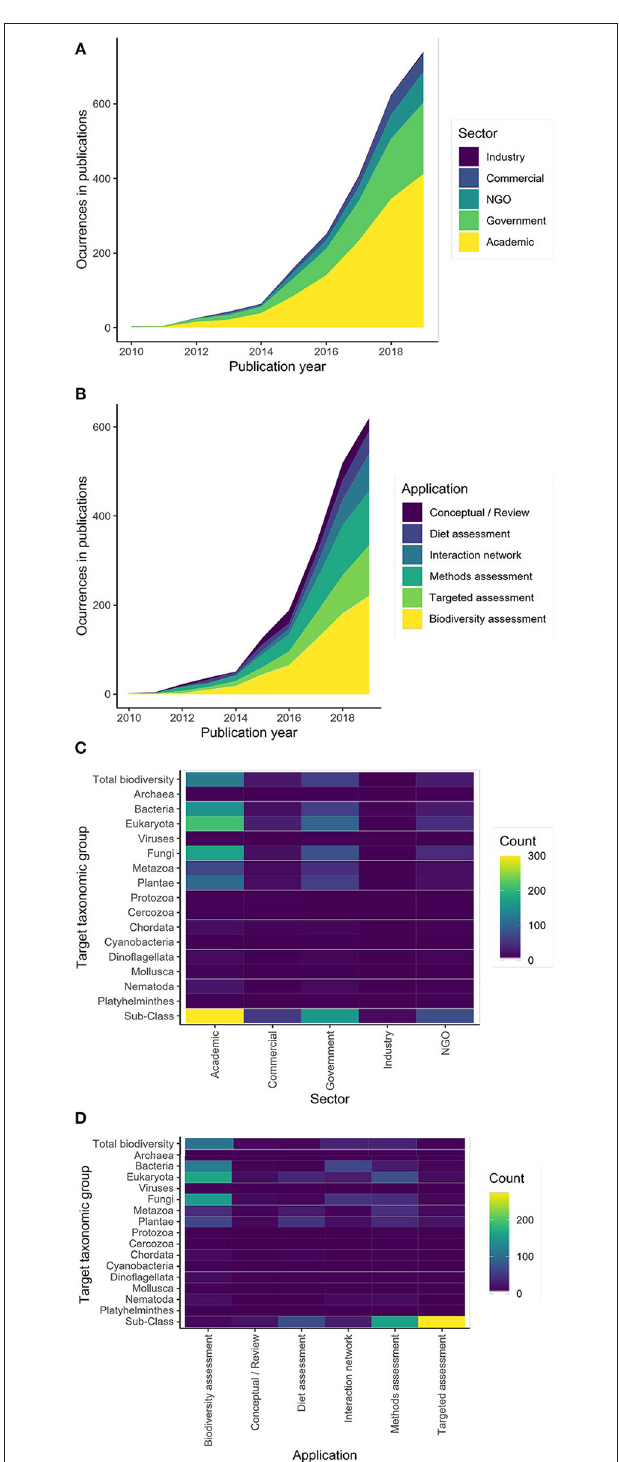
FIGURE 1 | Occurrences of (A) sectors and (B) applications in publications through time. Across all publications, the target taxonomy of each study is broken up by (C) sector and (D) application. Data come from a systematic literature search of 1,563 published articles on DNA metabarcoding ( Supplementary Material 1 ); for methodological details, see Supplementary Materials 2, 3